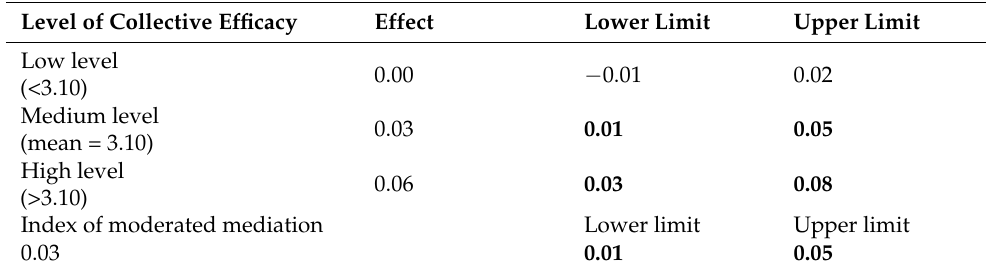
Table 3. Conditional effects of religiocentrism on support for interreligious violence via perceived injustice at the levels of collective